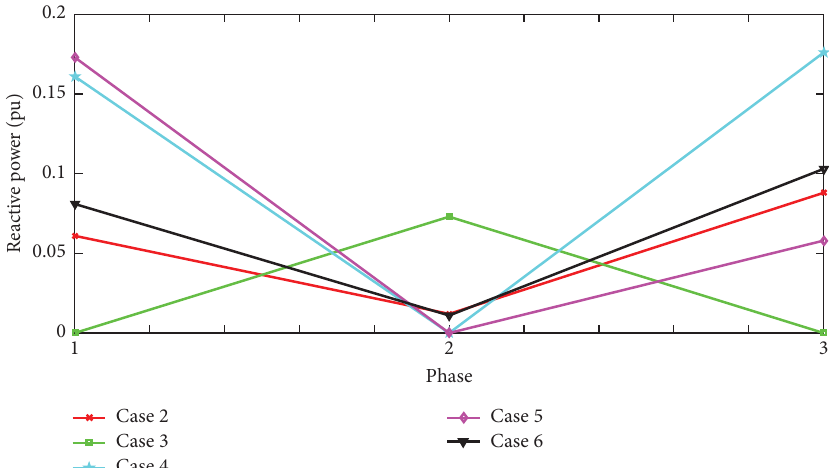
Figure 5: Reactive power generation of each phase of the solar system in diferent case